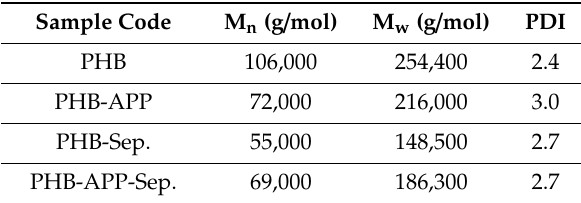
Table 7. Molecular weight of PHB and its corresponding blends.